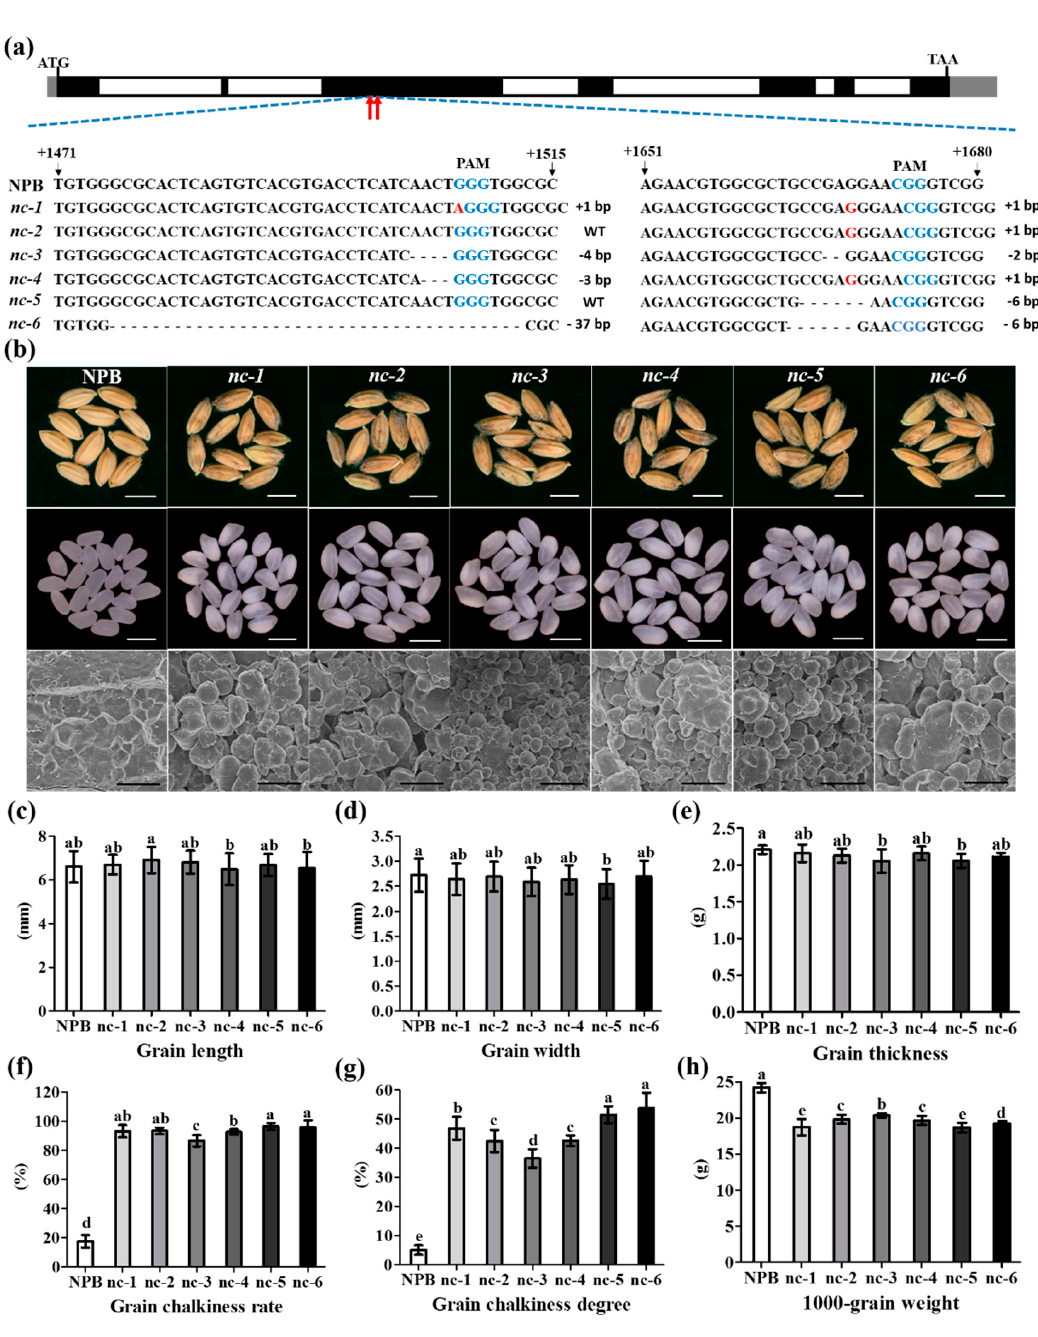
Figure 6. Sequencing validation and phenotypic analyses of six novel allelic mutants. ( a ) Sequencing validation of six novel allelic mutants. Blue color represents the PAM sequence of CRISPR/Cas9 system; red color represents insert bases; “-” represents deletion bases; the red arrows indicate the mutant sites mediated by CRISPR/Cas9 system. ( b ) Appearance and SEM of NPB and mutants grains. Magnification, ×1000; ( c – h ) Measurements of grain length ( n = 30), width ( n = 30), thickness ( n = 10), grain chalkiness rate ( n = 10), grain chalkiness degree ( n = 10) and 1000-grain weight ( n = 10) of NPB and mutant lines. Different letters indicate the statistical difference at p ≤ 0.05 by Duncan’s test. Values were means ± SD. Scale bars: bars of grains figures 5 mm; bars of SEM figures 10 μ m.